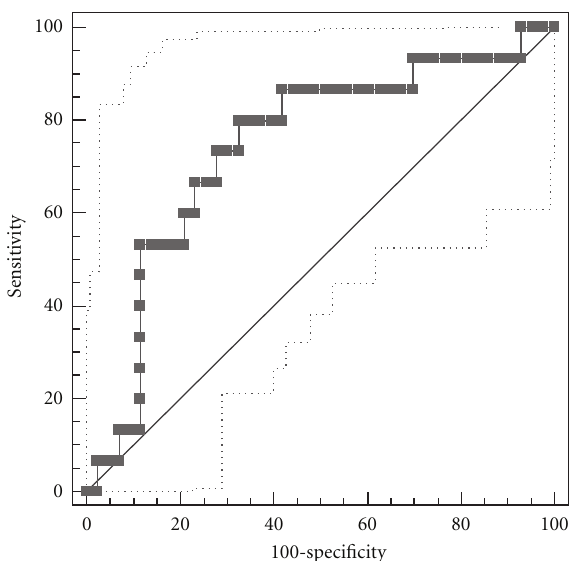
Figure 2: ROC (receiver operating characteristic) curve using HOMA quotient and δ 13 CO 2